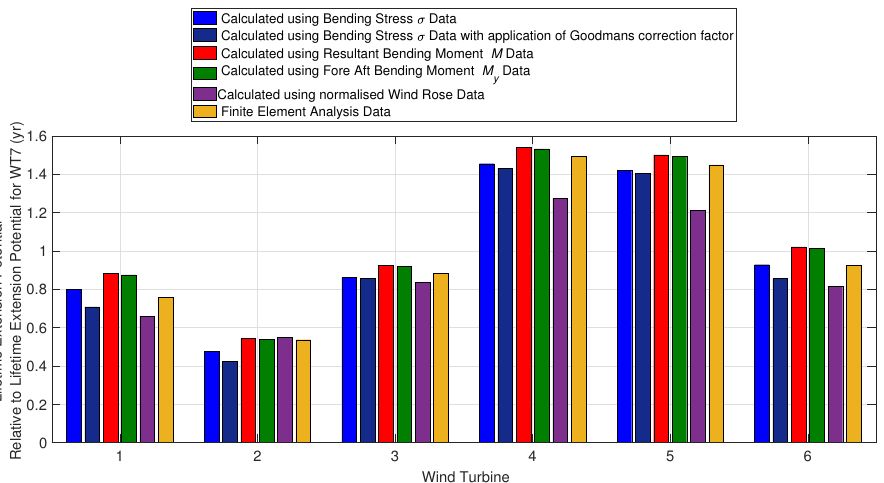
Figure 28. Relative lifetime extension potential for a range of scenarios range of wind